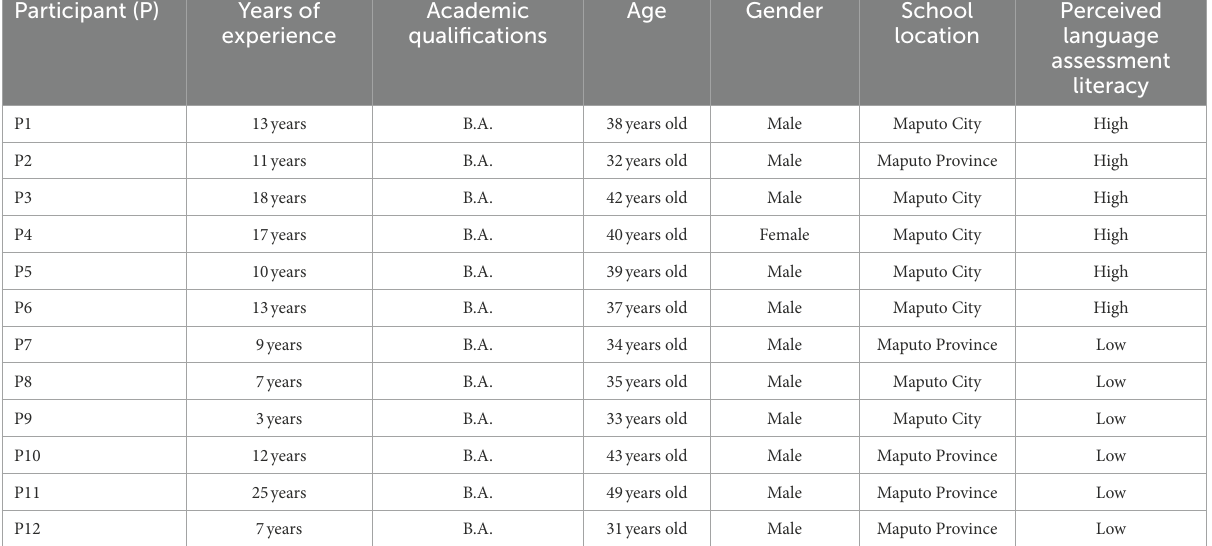
TABLE 1 Overview of